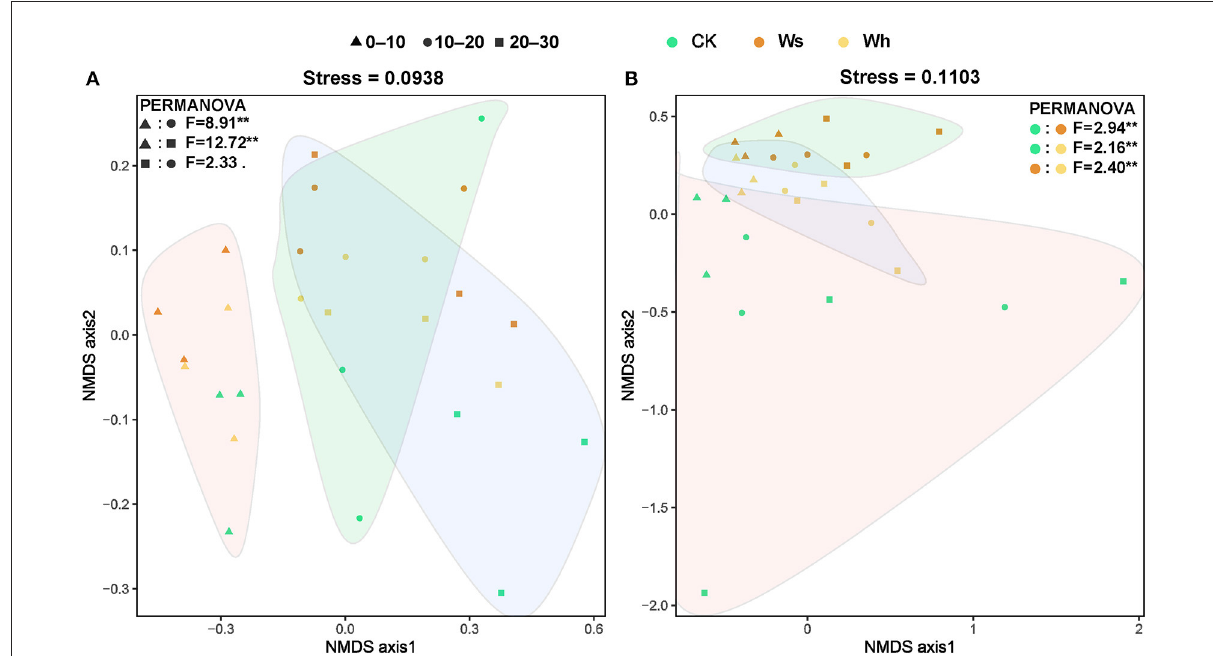
FIGURE3 Non-metric multidimensional scaling (NMDS) ordination of the soil bacterial (A) and fungal (B) community structure based on the Bray-Curtis distance. The filled graphs cover significantly different groups of bacteria and fungi communities by PERMANOVA. Ws, slight warming; Wh, high warming; **0.001 < p <